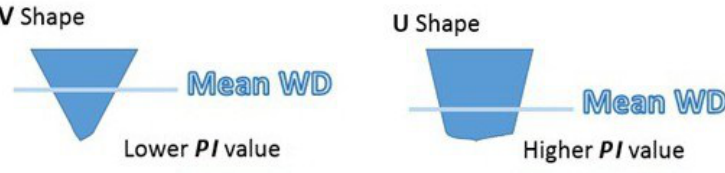
Figure 8. Schematic representation of two different type of pockmarks profiles and how the position of the mean will lead to lower or higher PI values.